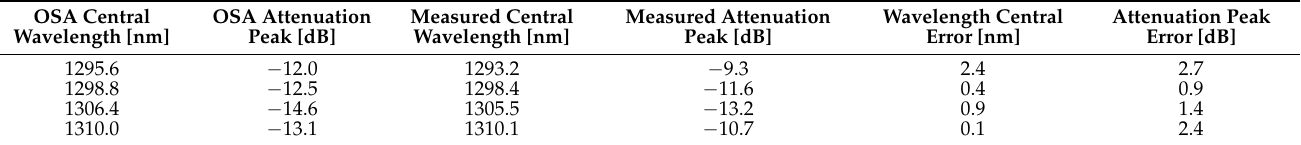
Table 2. Comparison of the broadband light source and OSA (Optical Spectrum Analyzer) results with the results obtained from the built interrogation